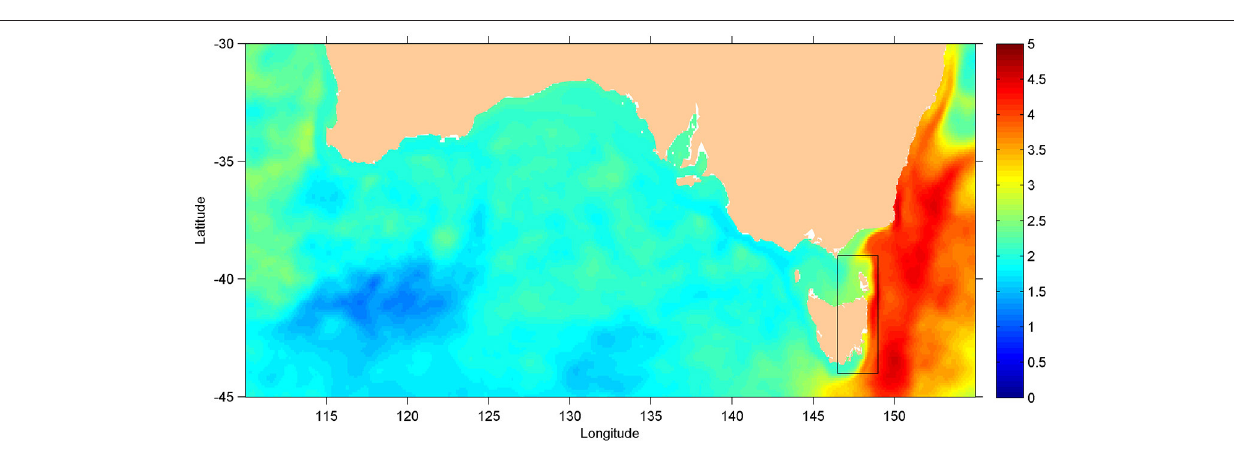
FIGURE 2 | Projected SST change over the period 2081-2100 relative to 1986-2005 for southern Australia based on output from the CSIRO-Downscaling project described in the text. Box shows the area considered in Figure 3